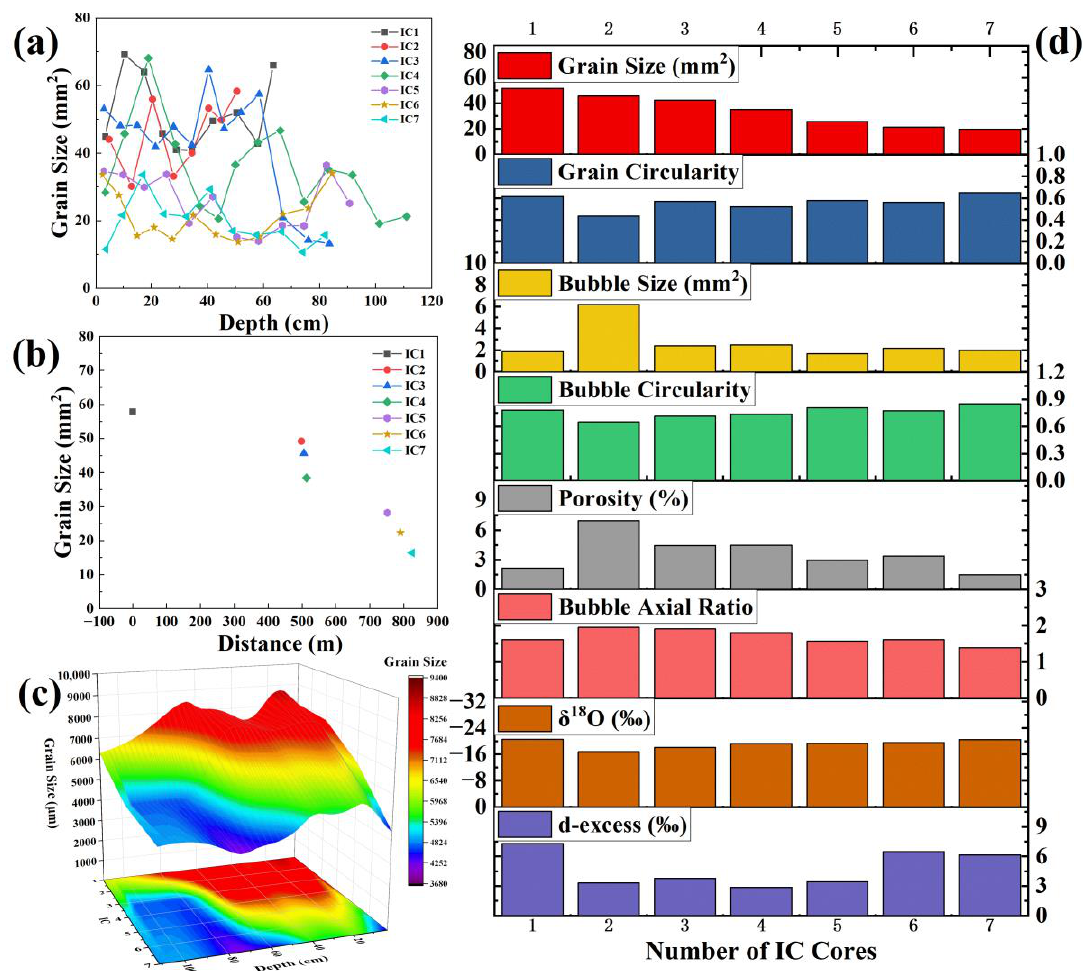
Figure 8. ( a ) Variations of IC grain sizes with depth; ( b ) variations of averaged grain sizes with the relative distances among different IC ice cores; ( c ) 3D smooth surface projection of grain size (μm), sample number and depth (cm). Grain size is the equivalent diameter corresponding to the grain average area. Smoothing method is adjacent-averaging, smoothing parameter is 0.05, total growth factor is 100; ( d ) averaged proxies of each IC core including grain size, grain circularity, bubble size, bubble circularity, porosity, bubble axial ratio, δ 18 O, and d-excess.